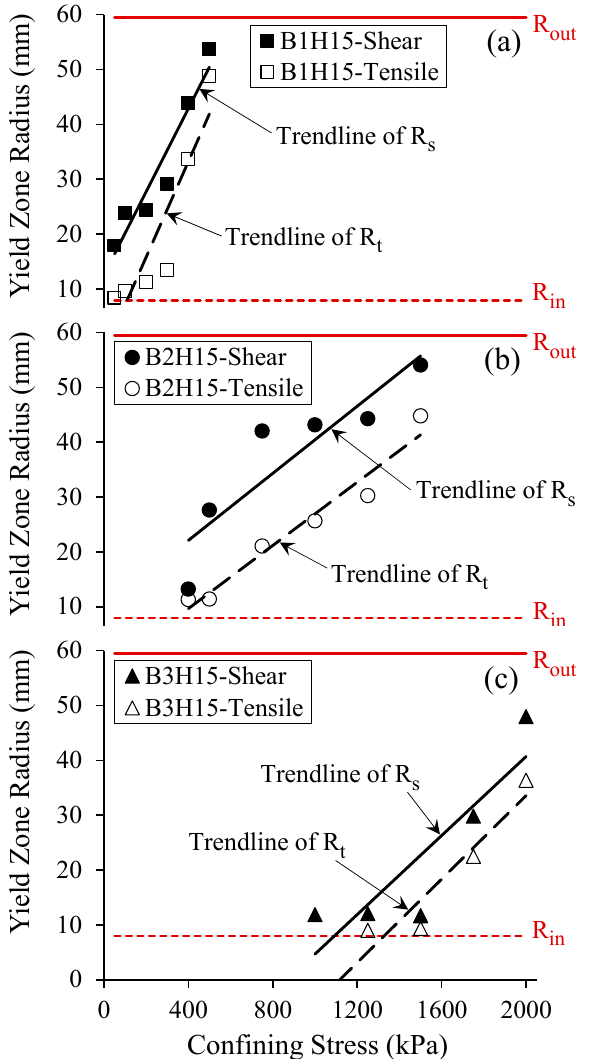
Figure 16. Variation of tensile and shear yield zone radii along with confining stress for: ( a ) B1H15 model; ( b ) B2H15 model; and ( c ) B3H15 model.